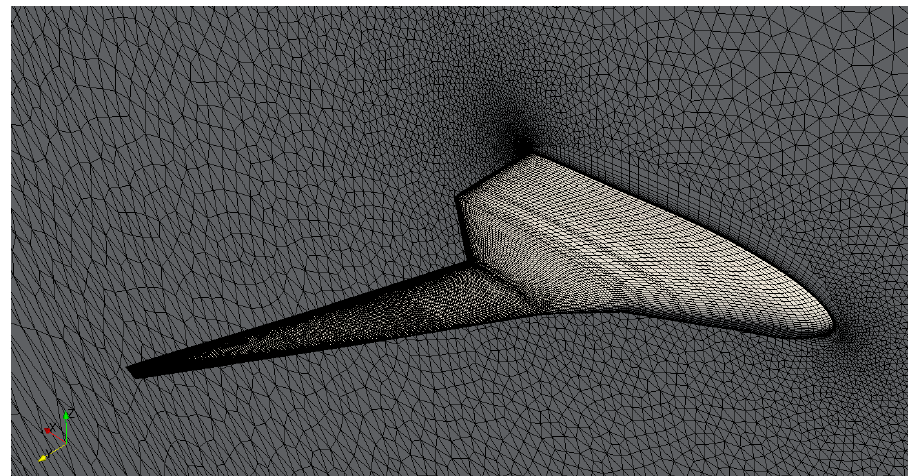
Figure 14. CFD mesh for the RANS simulation.